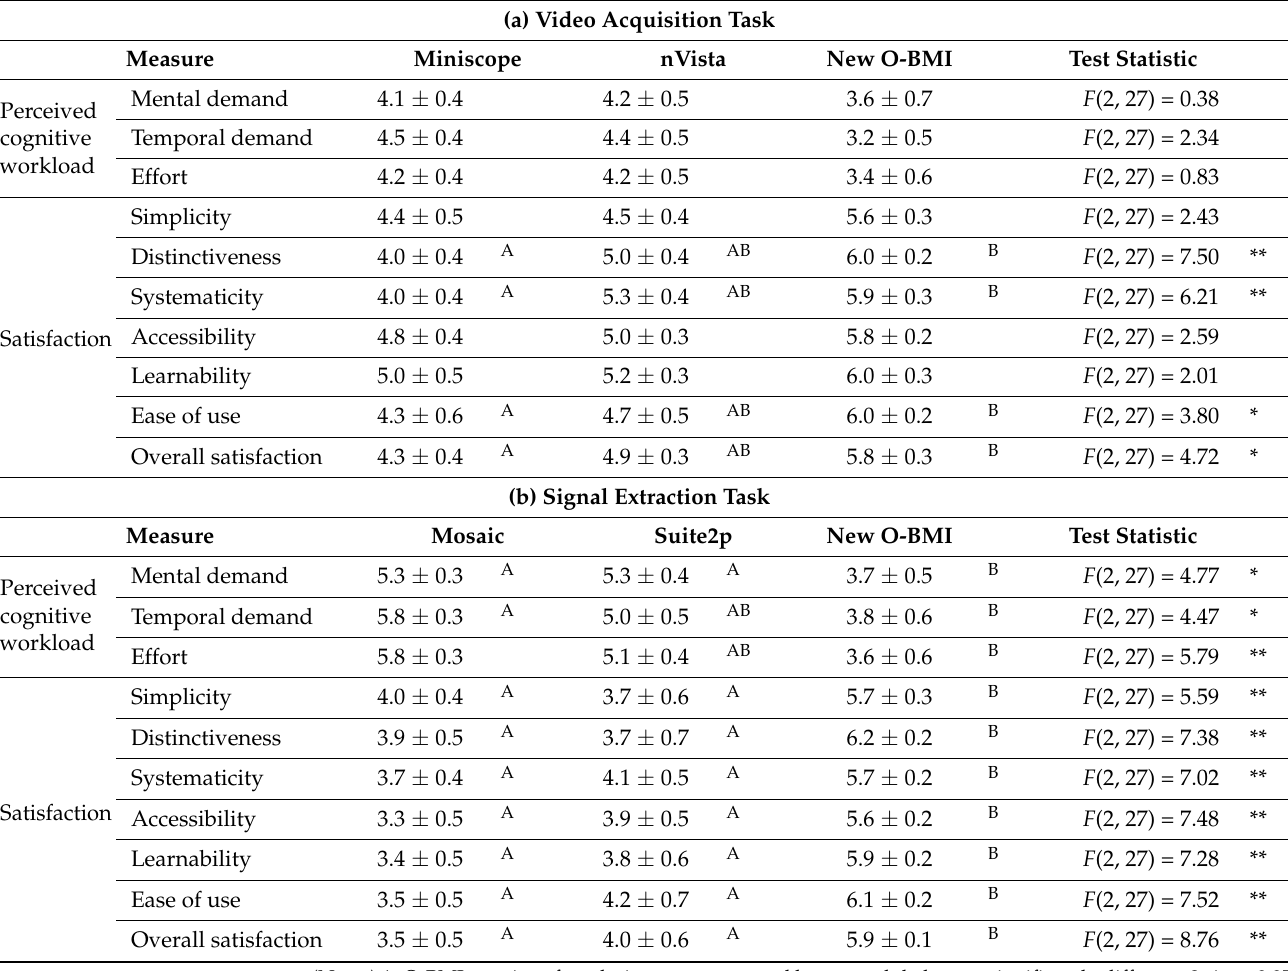
Table 3. Comparison of user interface designs of optical brain-machine interface (O-BMI) systems. (a) Video Acquisition